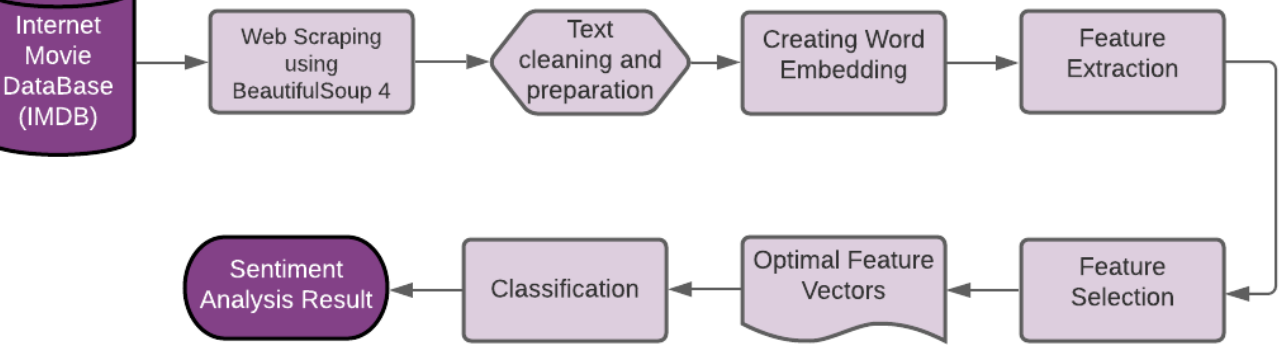
Figure 1. Key modules of the sentiment analysis-based Movie Recommendation System used in this research